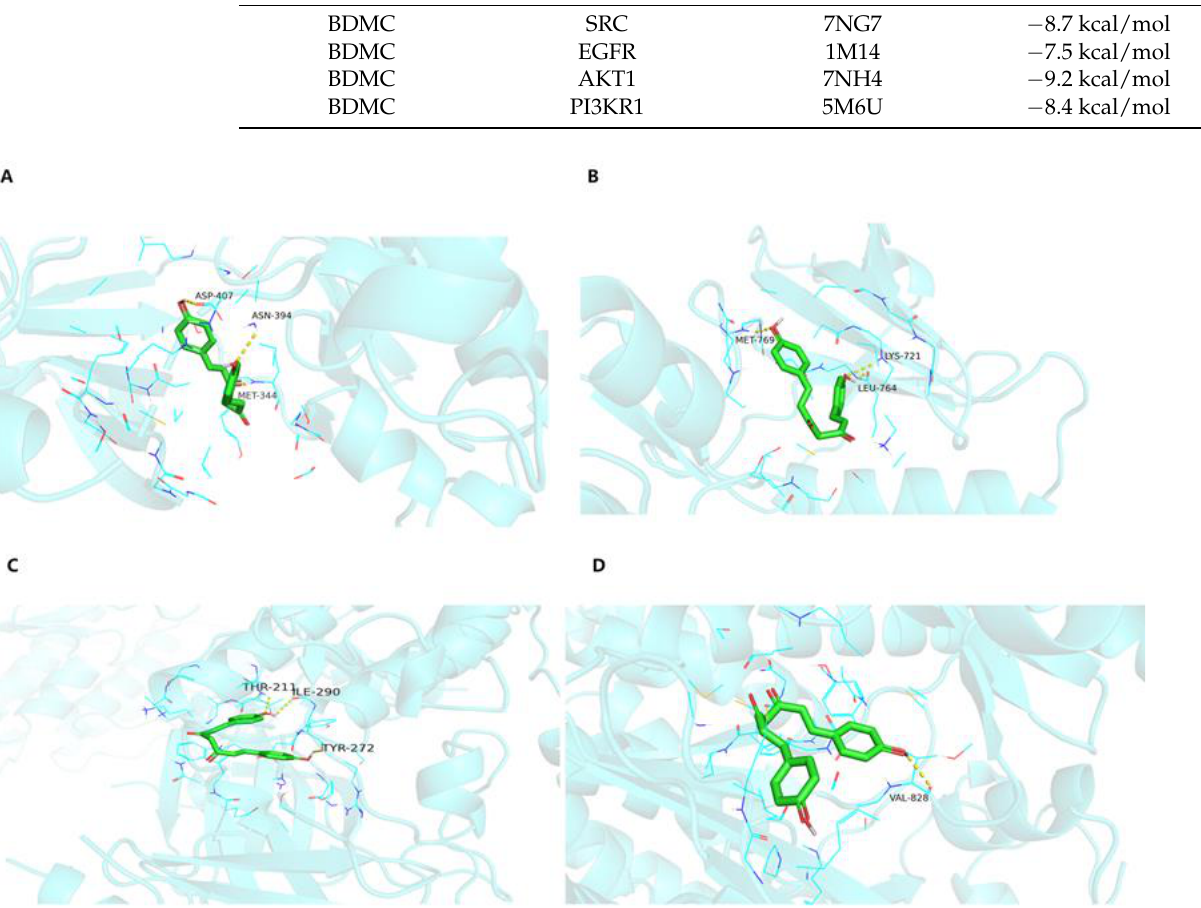
5 of 12 Figure 4. The construction BDMC-target-pathway network. The red inverted triangles represent BDMC, the blue ellipses represent target genes, and the yellow hexagons represent the top 10 KEGG